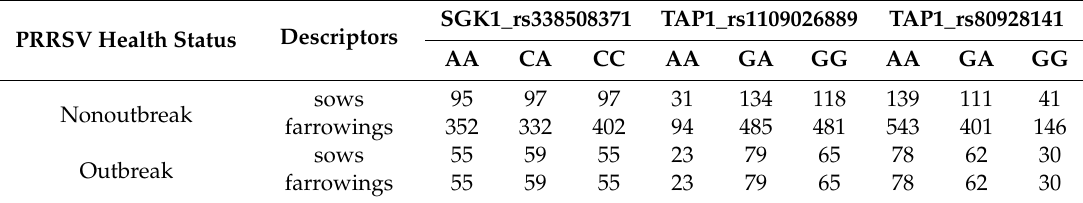
Table 2. Number of sows and farrowings per SGK1 and TAP1 genotypes and porcine reproductive and respiratory syndrome virus (PRRSV) health status of the